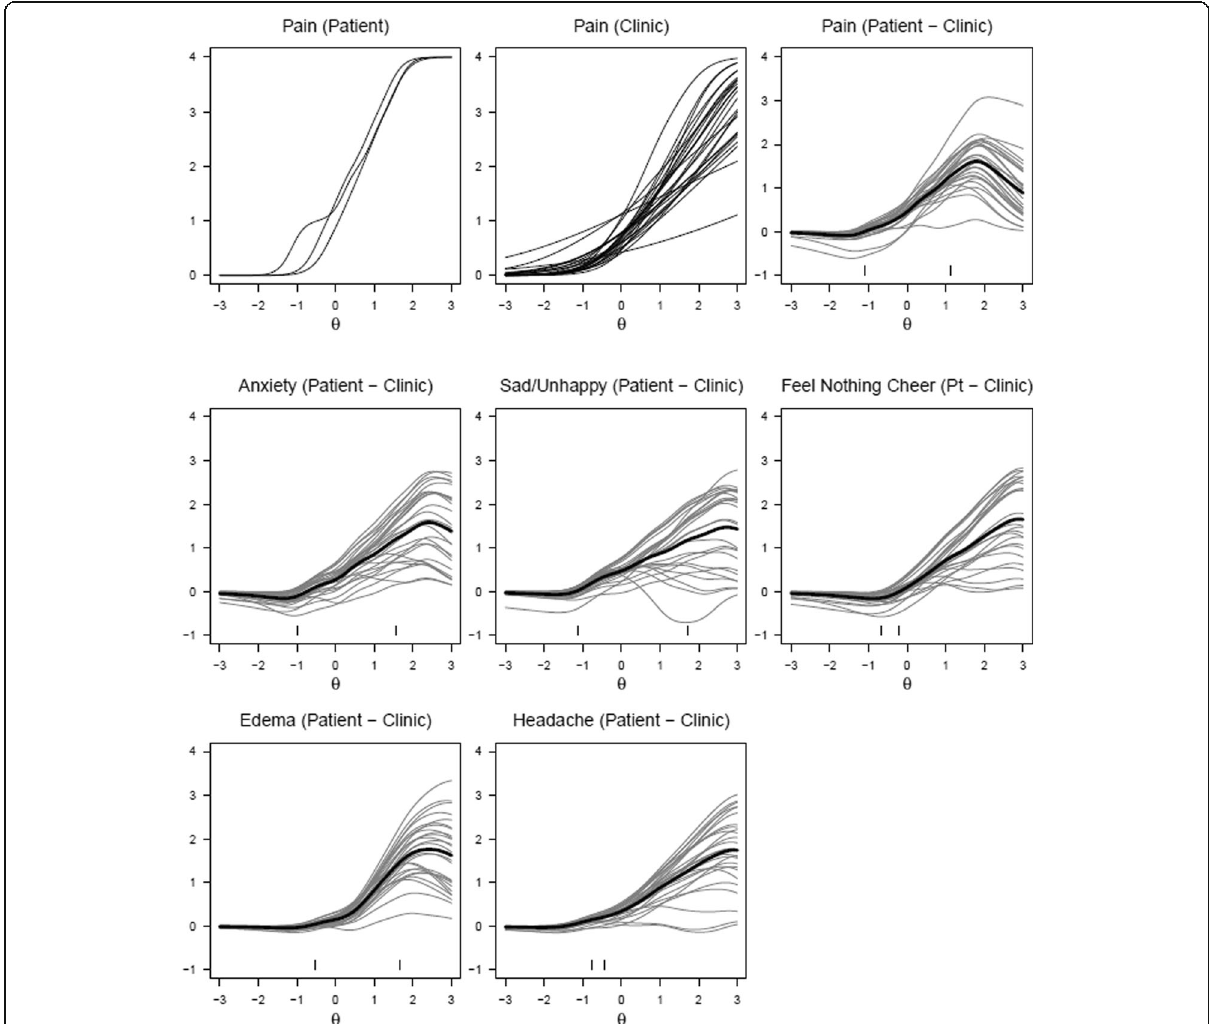
Fig. 3 Graded Response Model Estimates for Patients/Clinicians, and Difference between Patient and Clinicians for Three-Attribute Symptoms. Note: X-axis represents underlying distribution of AE in the population ( θ parameter in the GRM); Y-axis represents the model estimated AE ratings. In the case of pain, θ represents frequency, severity, and interference with daily